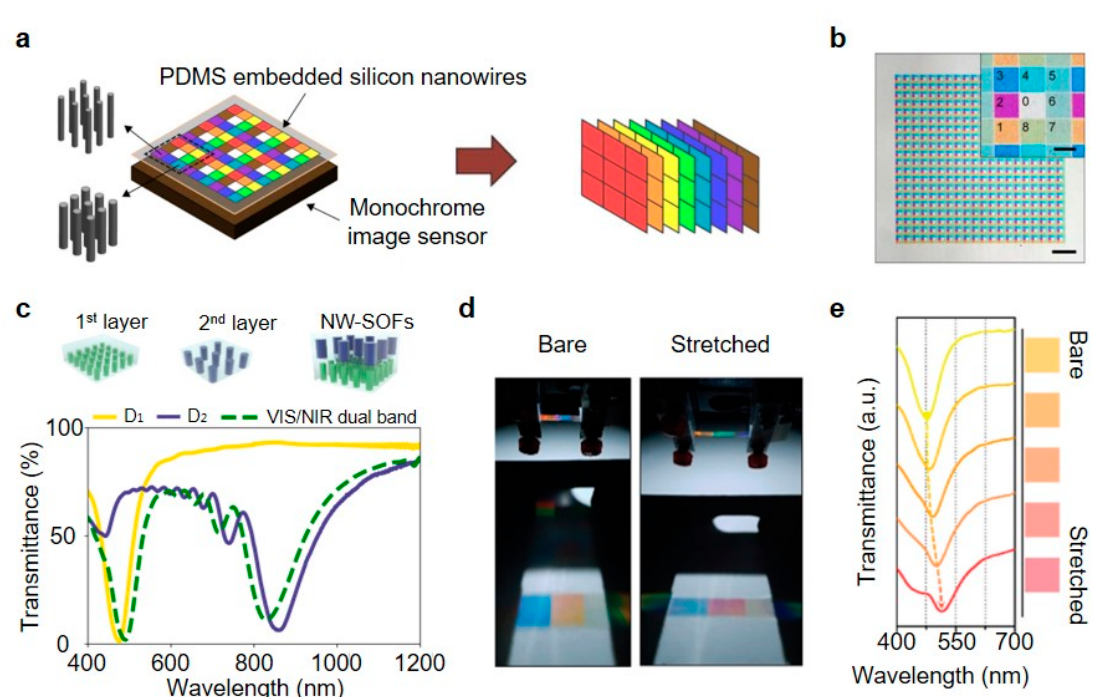
Figure 5. ( a ) Schematic of the multispectral filtering system with vertical Si nanowire array. ( b ) Optical microscopic image of integrated vertical Si nanowires on transparent polydimethylsiloxane (PDMS) substrate. Scale bars are 200 µ m and 20 µ m (inset). ( c ) Measured transmission spectra of the individual and (dotted-line) fabricated Si nanowire array-based stackable optical filters (Si NW-SOFs). The first layer has the diameter (D1) and period ( Λ 1) of 100 and 600 nm, respectively and 160 nm-diameter (D2) and a 1250 nm-period ( Λ 2) in the second layer. All are the height of 2 µ m. ( d ) Photographs of the mechanotunable nanowire optical filter. ( e ) Transmittance spectra of the Si nanowire arrays and color variations of the Si nanowire arrays along the stretched degree. ( a , b ) reprinted by permission from Springer Nature: Springer Scientific Reports [103], Copyright 2013; ( c ) reprinted from [105], with permission from Wiley; ( d , e ) reprinted from [106], with permission from De